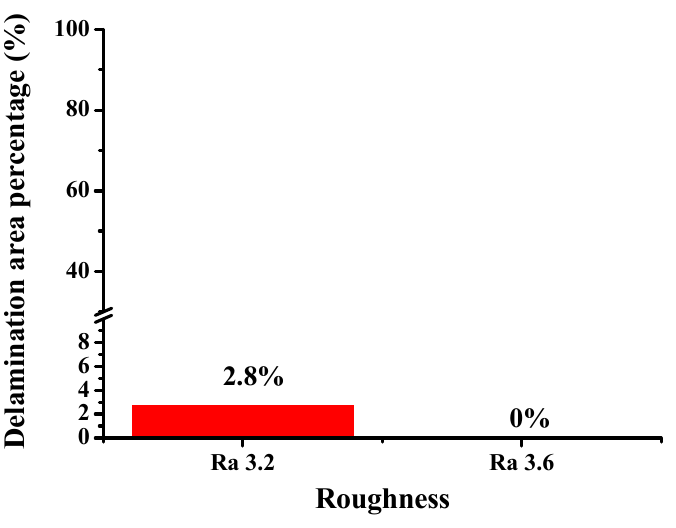
Figure 13. Roughness experiment.